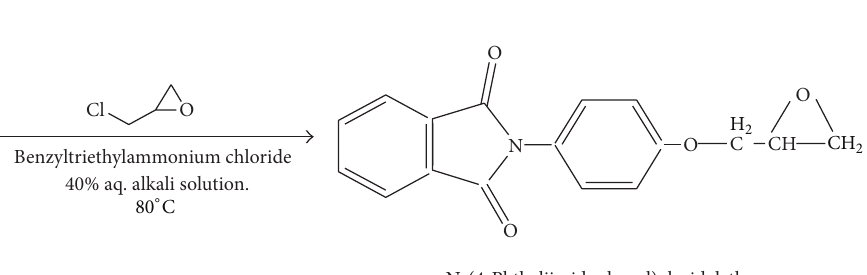
Scheme 1: Synthesis of PPGE.